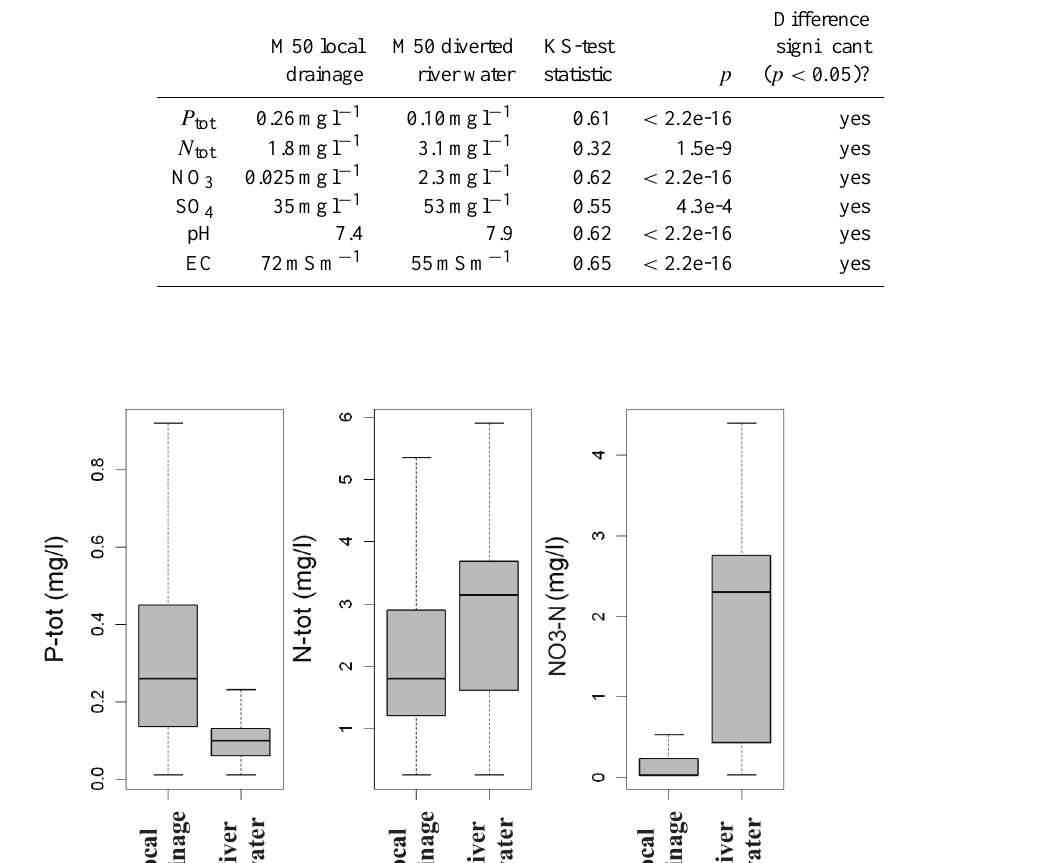
Table 1. Results of the non-parametric Kolmogorov-Smirnov tests on the difference between the solute concentrations in local drainage and diverted river water.